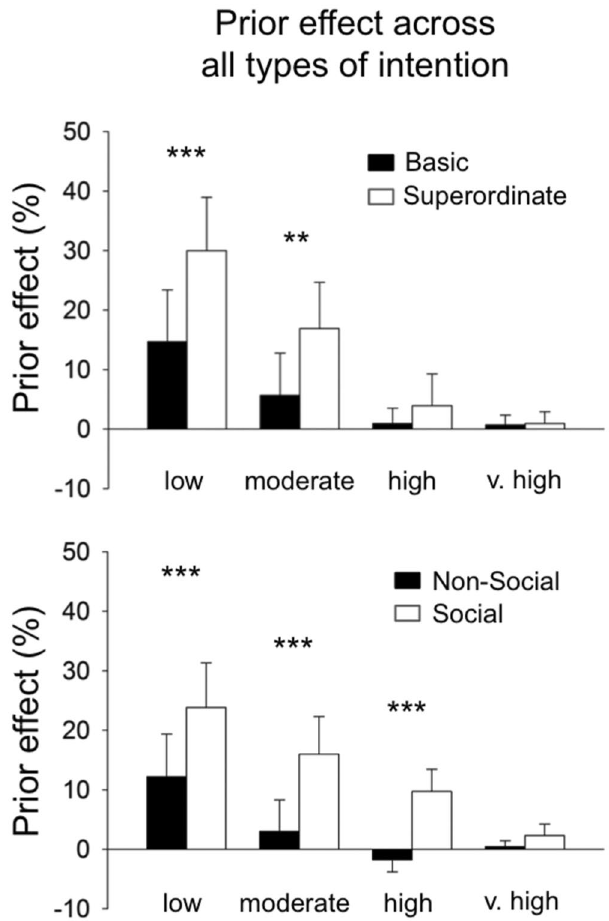
Figure 3. Prior effect (%) as a function of visuomotor evidence (from low to very high ). The greater the prior effect, the more participants respond toward the likely (i.e., biased) intention (see Material and Methods, “Behavioural analyses”). Top panel : experiment 1, comparing Non-Social ‘Basic’ vs. Non-Social ‘Superordinate’ intentions; Bottom panel : experiment 2, comparing ‘Non-Social’ Basic vs. ‘Social’ Basic intentions. The prior-by- evidence interaction is significant in both experiments. Three-stars: P < 0.001; two-stars: P <